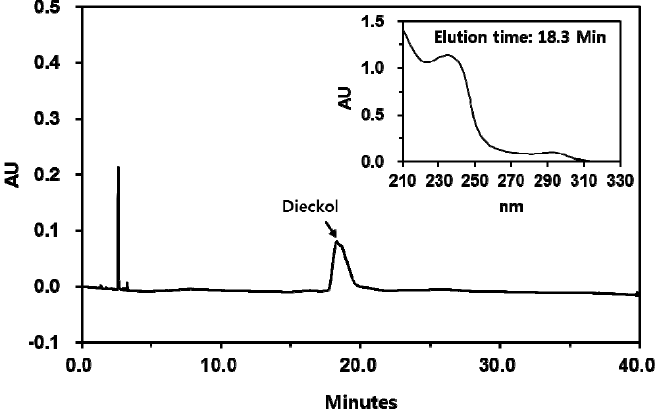
Figure 5. High performance liquid chromatography (HPLC) of dieckol isolated from Ecklonia cava . The chromatograms detected at 280 nm are shown. The UV absorption spectrum of a major peak (dieckol) is shown in inset.